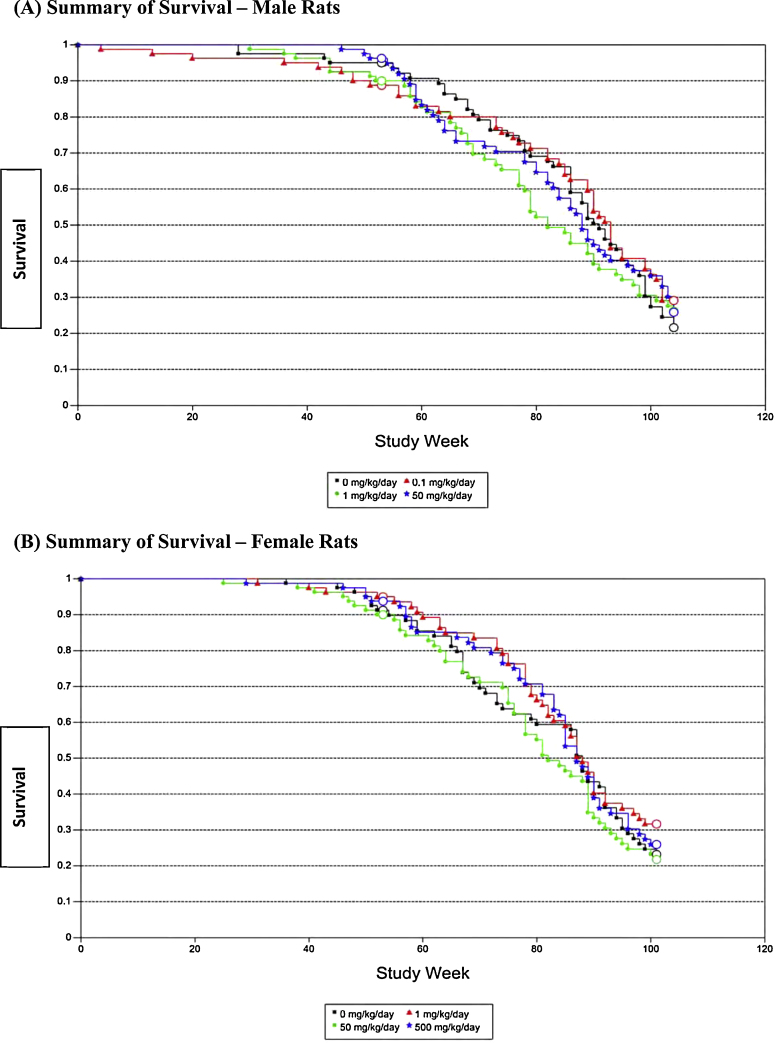
Kaplan–Meier survival curves for rats treated with ammonium 2,3,3,3-tetrafluoro-2-(heptafluoropropoxy)-propanoate for 104 weeks (male) or 101 weeks (female). (A) Survival curve of male rats treated with either 0, 0.1, 1 or 50 mg/kg. p > 0.05. (B) Survival curve of female rats treated with either 0, 1, 50 or 500 mg/kg, p > 0.05.